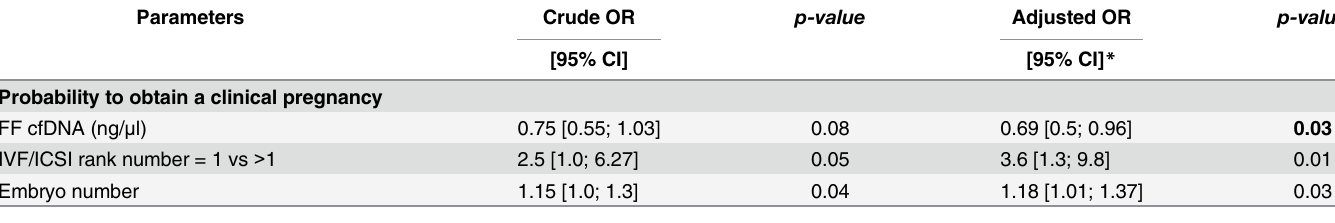
Table 4. Multivariate logistic model showing the prediction of clinical pregnancy according to the cell-free DNA level in follicular fluid pools.